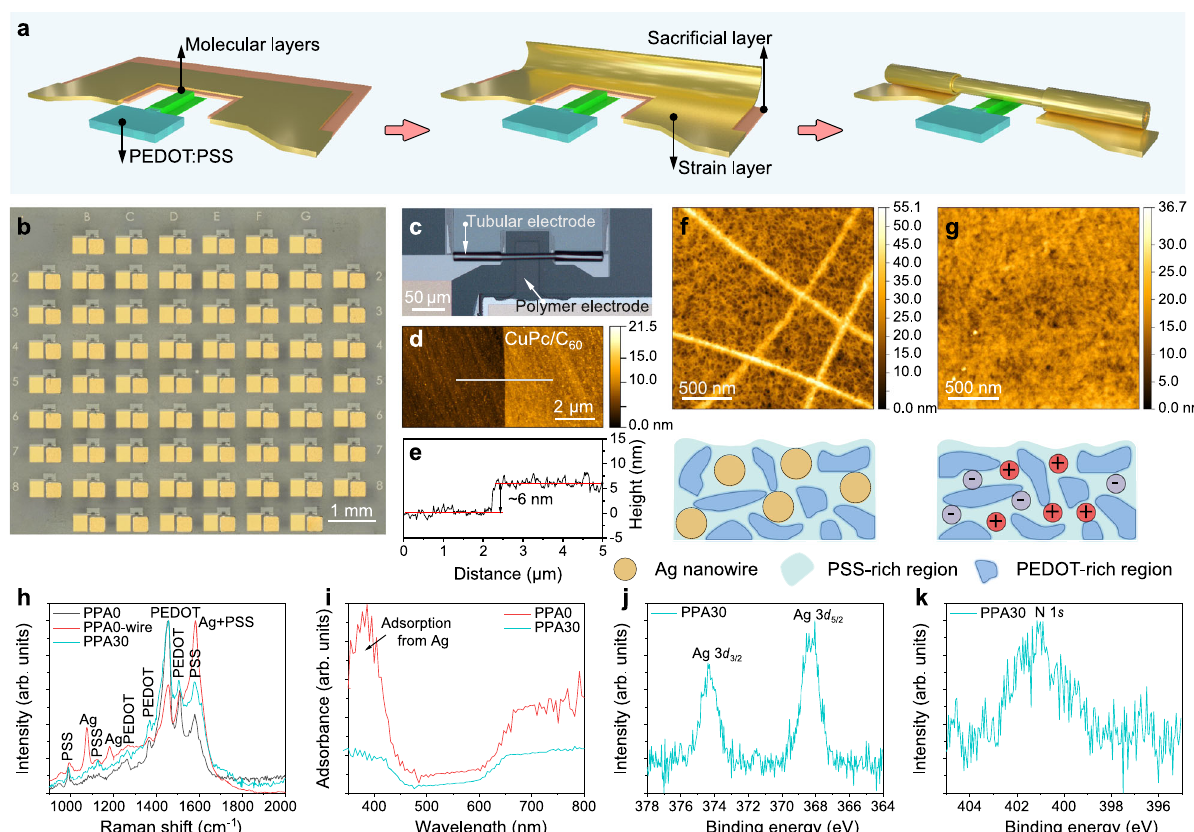
Fig. 2 Design and microfabrication of the molecular devices. a Formation of rolled-up soft contacts. The fi nger-shaped mesa structure provides a platform for the bottom electrode, onto which molecular layers are grown. During the selective etching of the sacri fi cial layer GeO x by deionized (DI) water, the Au/ Ti/Cr nanomembranes release their built-in stress and roll up. After rolling, the rolled-up metallic nanomembrane bonds as a top electrode to the molecule layer below, forming a sandwich structure. b Micrograph of the molecular device array. c – e Typical single device based on a rolled-up soft contact ( c ). The width of the bottom electrode and the diameter of the rolled-up metallic tube are ~40 μ m and ~10 μ m, respectively. AFM image of CuPc (3 nm)/CuPc (3 nm) grown on the wafer ( d ) and the corresponding height pro fi le ( e ). f , g AFM images of the spin-coated PEDOT:PSS:AgNWs fi lm before ( f ) and after ( g ) 30 s wet etching. Schematic illustrations are also given. h , i Raman spectrum ( h ) and adsorption coef fi cient pro fi le ( i ) of the spin-coated PEDOT:PSS:AgNWs fi lm before (denoted as PPA0) and after 30 s wet-etching (denoted as PPA30). j , k XPS spectra (Al-K α = 1486.6 eV) corresponding to Ag 3 d ( j ) and N 1 s ( k ) of the etched PEDOT:PSS:AgNWs fi